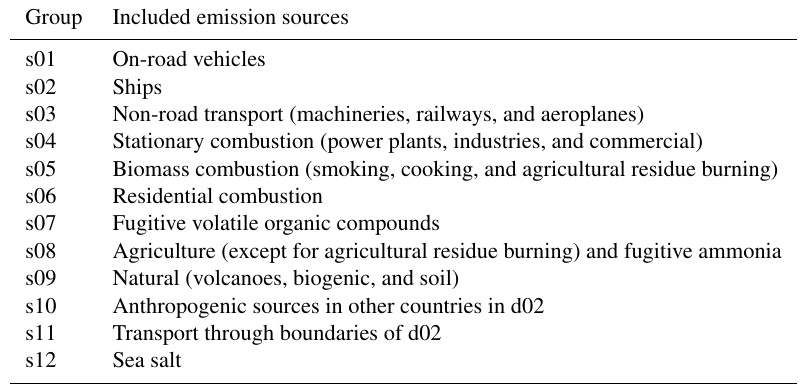
Table 1. Emission source groups for which sensitivities and apportionments were evaluated in this study. Group Included emission sources s01 On-road